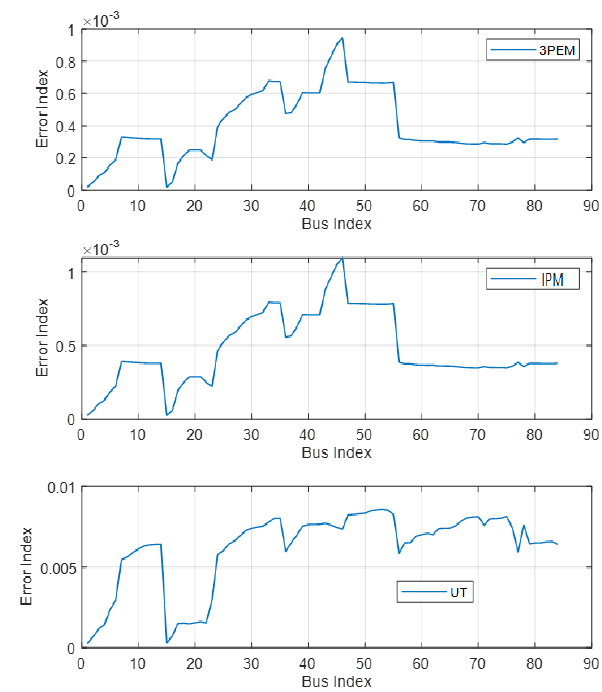
Fig.15. The comparative diagram of the squares of the mean bus voltage